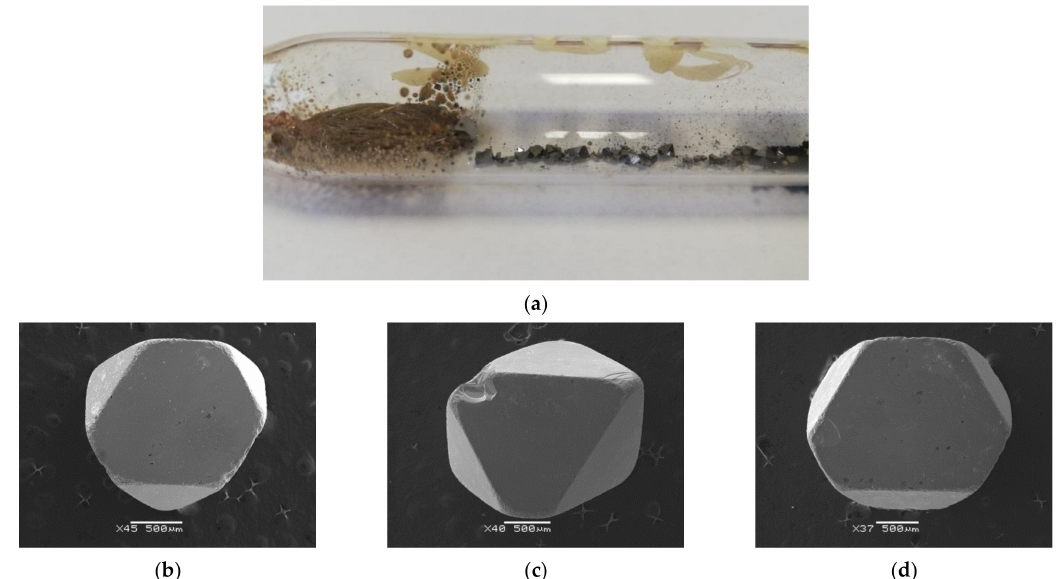
Figure 4. ( a ) A part of quartz ampoule with obtained ZnCr 2 Se 4 :Pb single crystals. Examples of single crystals obtained in the ZnCr 2 Se 4 :Pb system: ( b ) Zn 0.94 Pb 0.06 Cr 2 Se 4 , ( c ) Zn 0.92 Pb 0.09 Cr 2 Se 4 , ( d ) Zn 0.88 Pb 0.12 Cr 2 Se